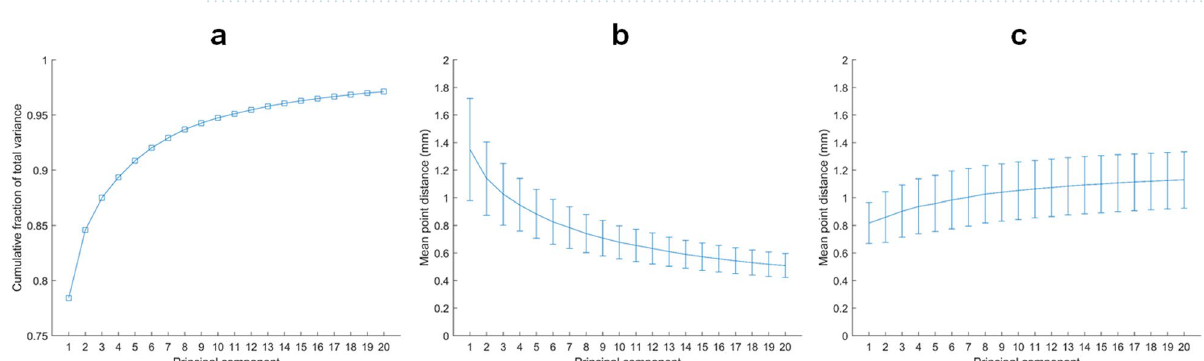
Figure 5. Compactness ( a ), generalization ability ( b ) and specificity ( c ) plots for the first 20 principal components of the statistical shape model. The compactness plot ( a ) shows the cumulative fraction of total variance. The generalization ability plot ( b ) displays the average distance between the original and reconstructed samples using leave-one-out cross-validation. The specificity plot ( c ) shows the average distance between randomly generated instances and their nearest member in the original data